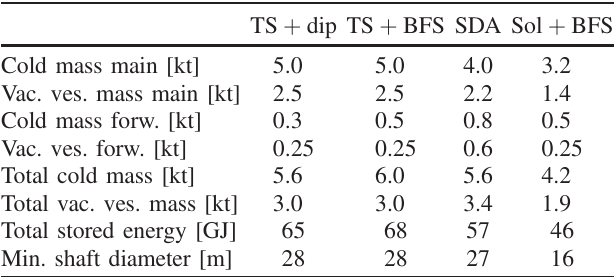
TABLE I. Main properties of the magnet